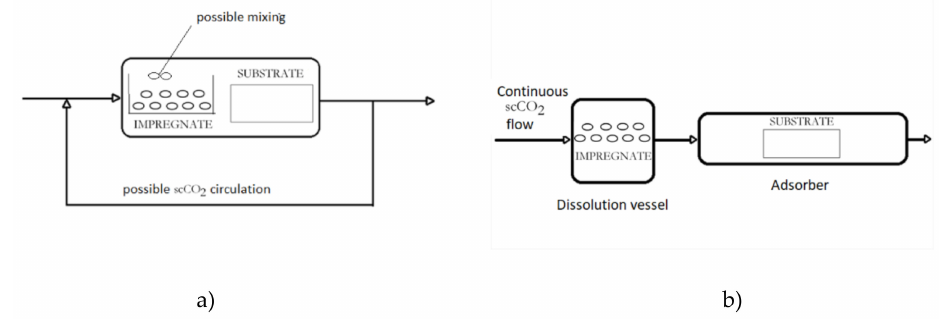
Figure 1. Simplified presentation of Supercritical Solvent Impregnation (SSI) modes: ( a ) batch; ( b )